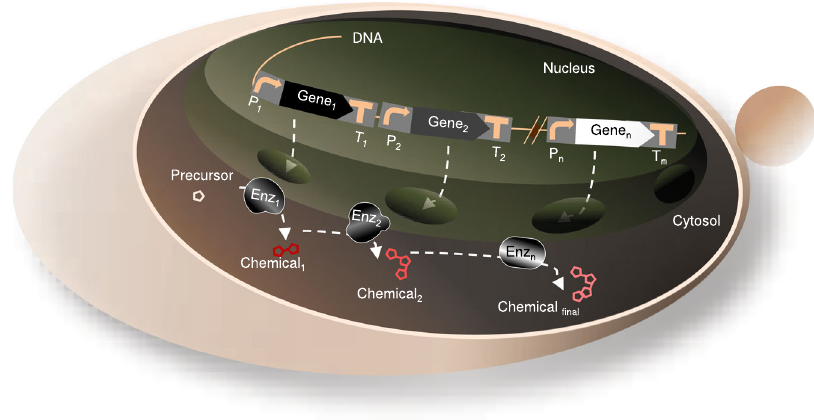
Fig. 1 | Schematic overview of the principle of heterologous chemical produc- tion in yeast. The DNA sequences of genes and regulatory elements, promoters, and terminators (to, respectively, start and terminate the transcription of the individualgenes)areengineeredintotheDNAlocatedinsidethenucleusinthecell. Followed by translation using the host translational machinery, the expressed